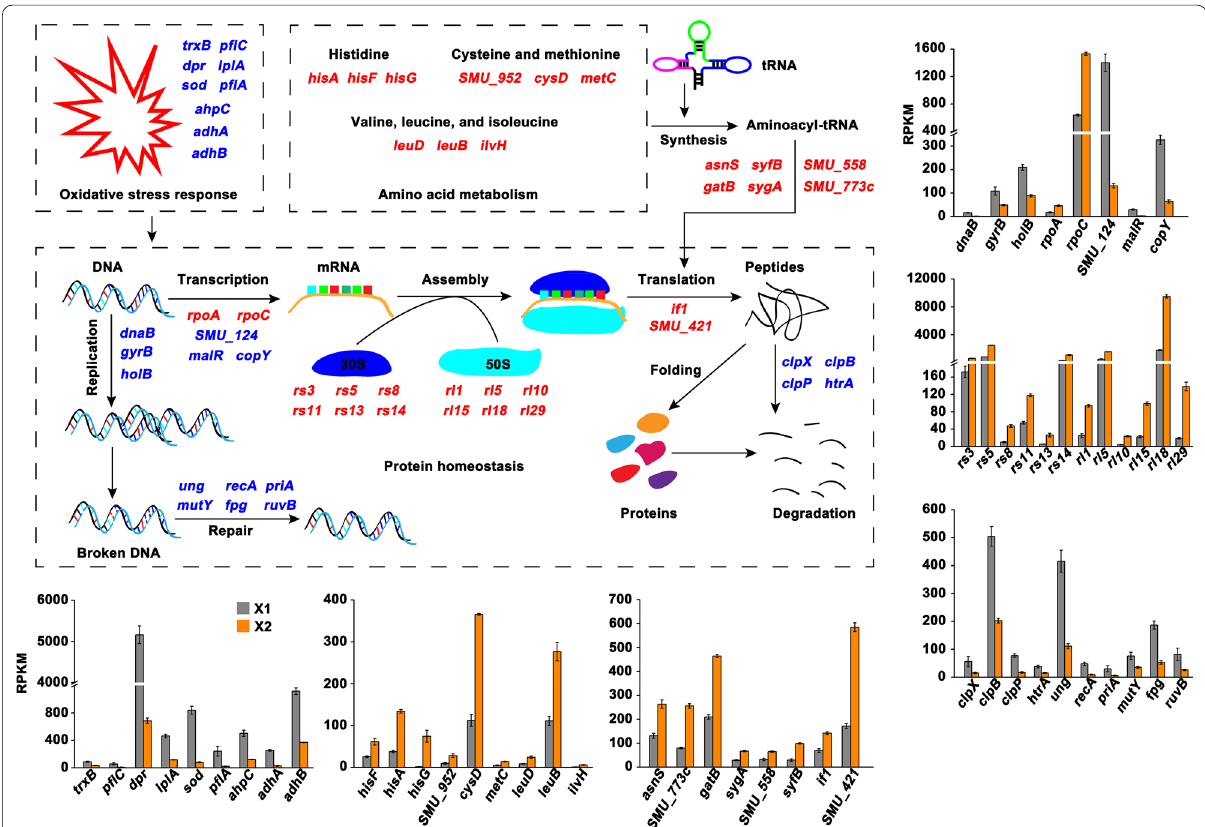
Fig. 9 Changes in the expression of genes implicated in protein homeostasis, amino acid metabolism, DNA replication, repair, and recombination, and oxidative stress response. The upregulated and downregulated genes were denoted as red and blue texts, respectively. Expression level shown as RPKM was displayed by mean standard deviation. The detailed information of these DEGs were presented in Additional file 1: Tables S3 and ±